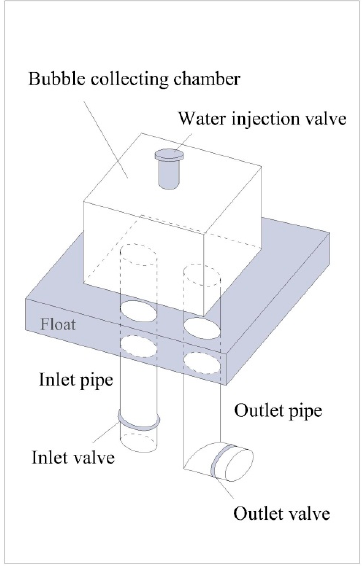
Figure 3. Diagram of the equipment for the measurement of oxygen dissolution efficiency.